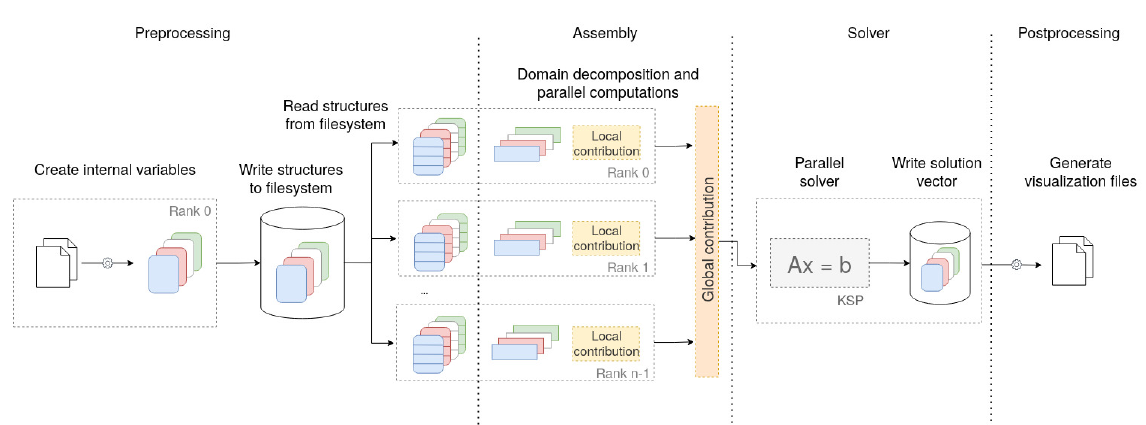
Figure 2. Block diagram overview of PETGEM